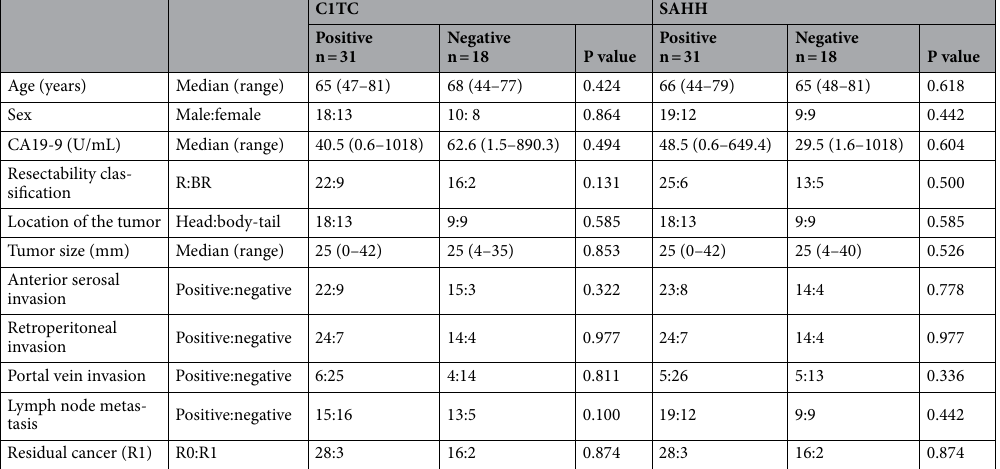
Table 2. Patient clinicopathological characteristics of positive and negative group in C1TC and SAHH.